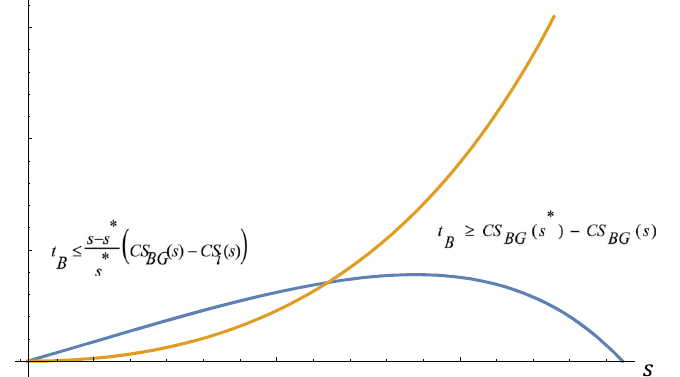
Fig. 8 Participation constraints (B8) and (B10) for different values of the size of the buyer group,